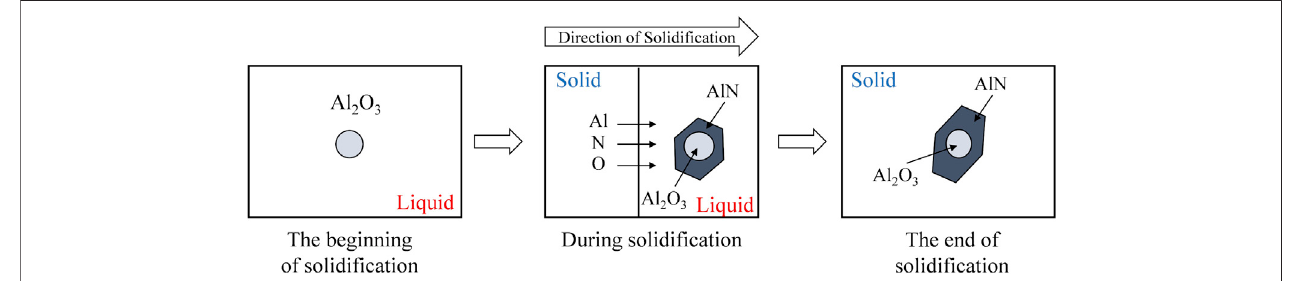
FIGURE 11 | A schematic illustration of formation of complex inclusion of AlN-Al 2 O 3 during the solidi fi cation process.